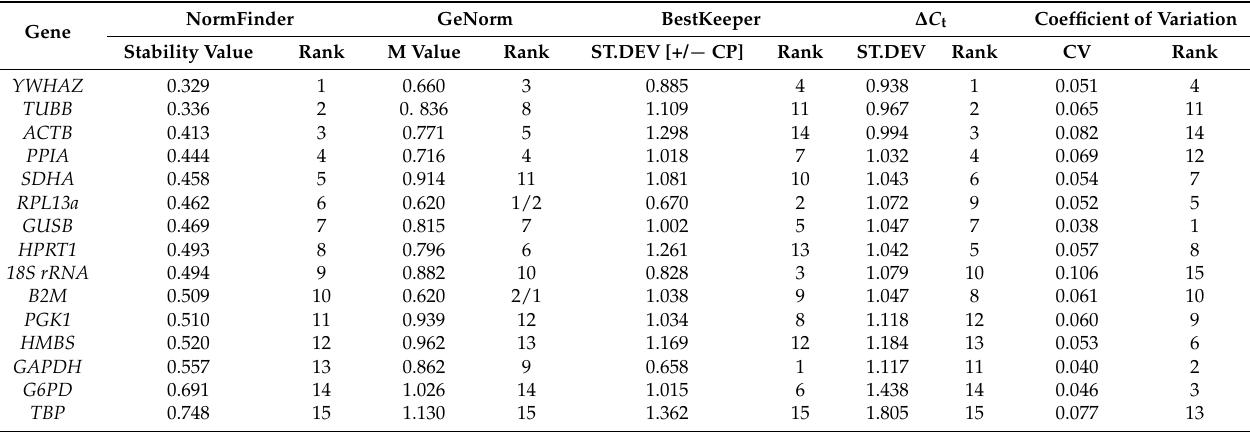
Table 4. Ranking of the expression of candidate HKG under physiological pH culture conditions (pH